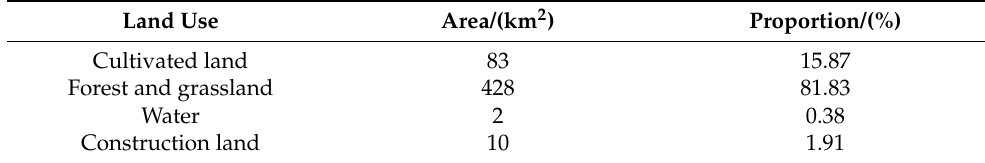
Table 5. Statistics of land use area in ecological source area.